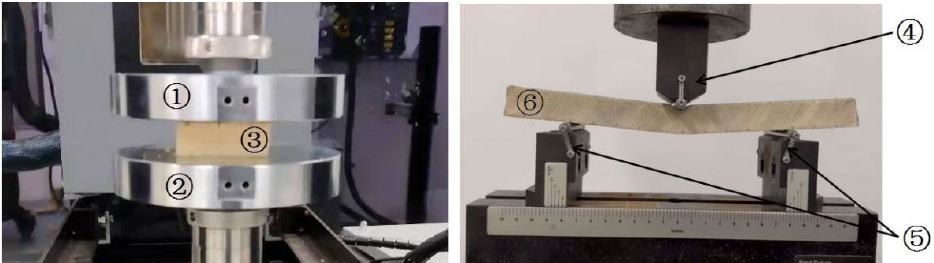
Figure 20. Flat compression and bending test, 1—upper flat pressing fixture, 2—down flat pressing fixture, 3—flat compression test sample, 4—upper loading-rod, 5—down braces, 6—bending test sample.